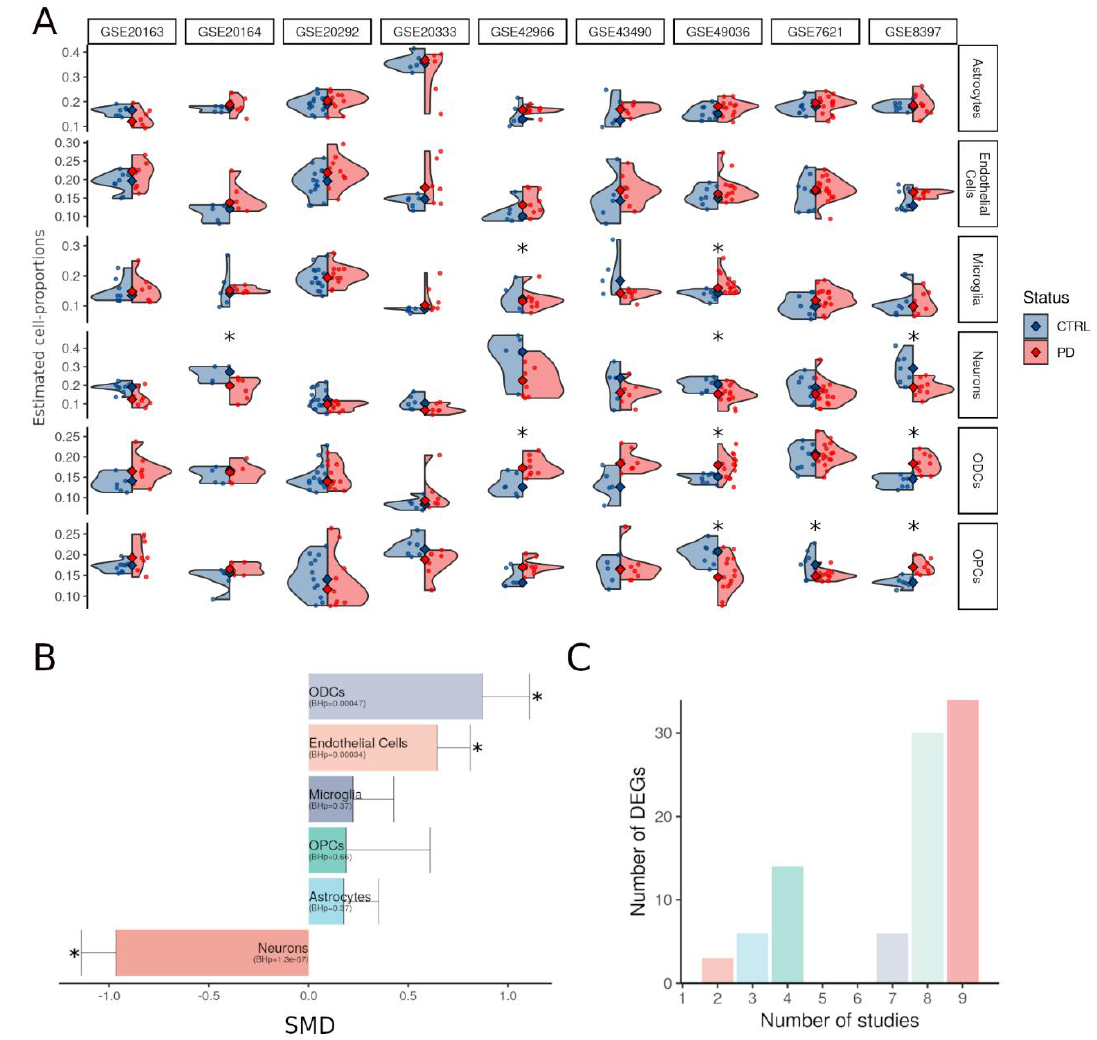
Figure 2. Cyto-architectural heterogeneity as estimated from bulk transcriptomics using the decon- volution strategy of TOAST. ( A ) Cell estimates of six cell types in substantia nigra across different datasets and conditions. Blue, CTRL; red, PD. Significant variations are indicated by asterisk ( p < 0.05). ( B ) Bar plot of the standardized mean differences (SMD) in cell estimates from the random-effects meta-analysis conducted with metafor. BH-adjusted p -values are reported between brackets, significant differences are indicated by asterisks “*” (BH p < 0.05), and standard errors for each cell type are reported as error bars. ( C ) Number of DEGs of the cell proportion-aware LMM probed by a specific number of microarrays in our dataset.